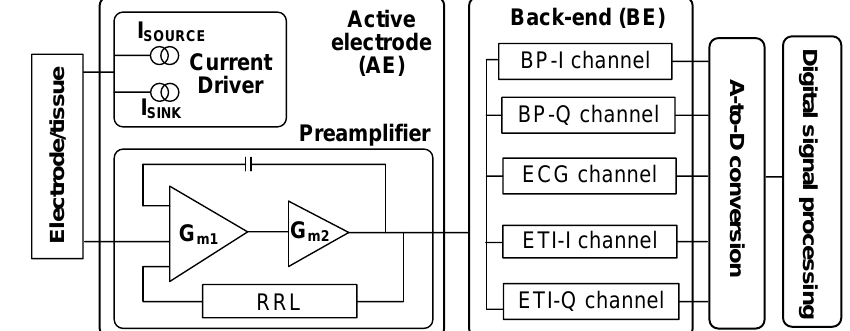
Figure 1. Block diagram for the ECG/ETI measurement system.